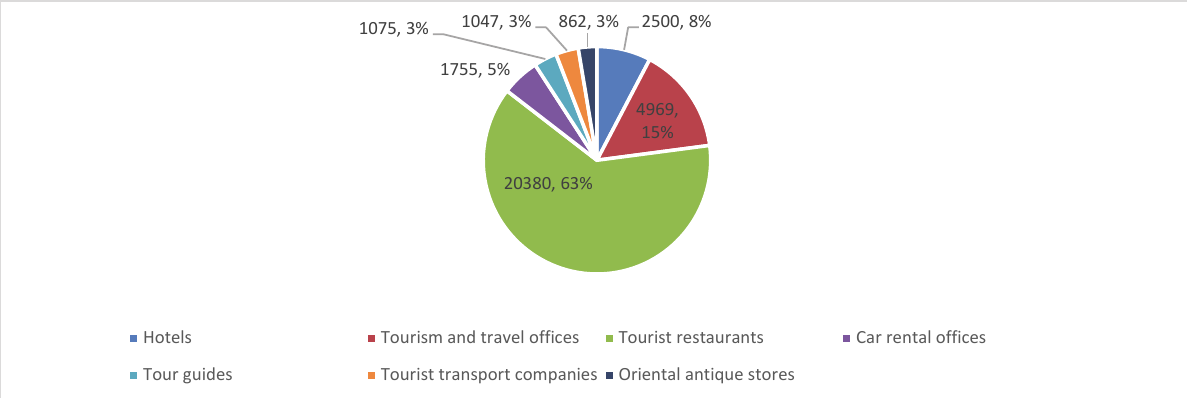
Fig. 1. The Number of Workers in Tourism Sector Source: (Statistics and Ministry of Tourism, 2018).